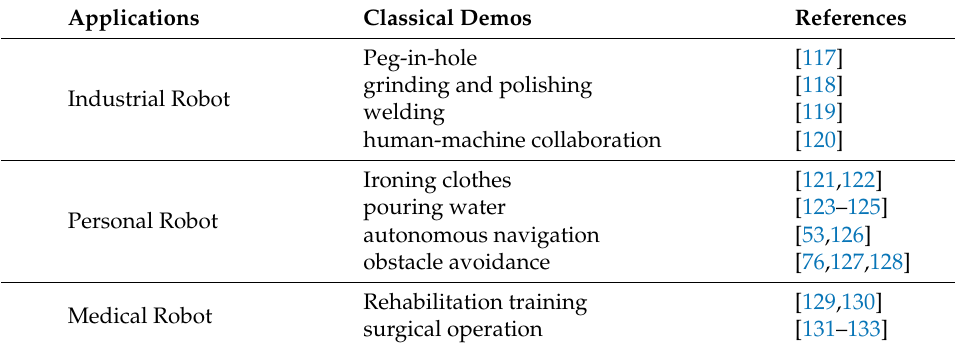
Table 4. Robot learning application